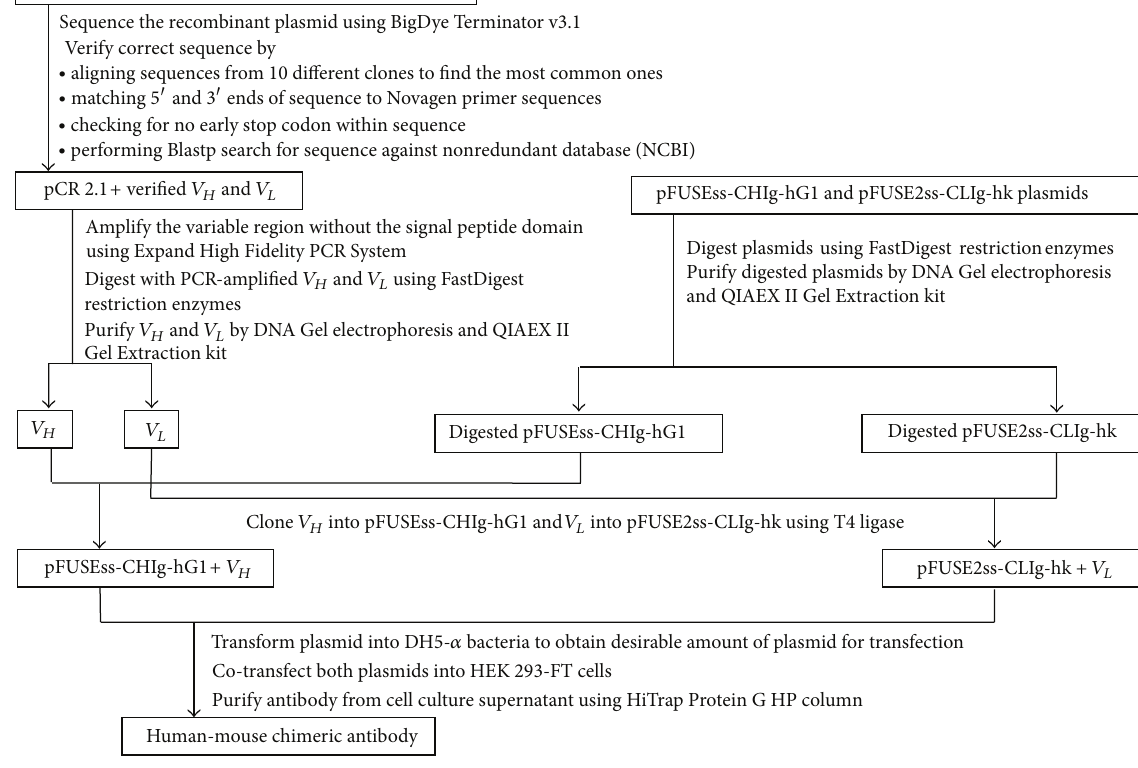
Figure 1: Basic molecular procedure for converting mouse mAbs to human-mouse chimeric